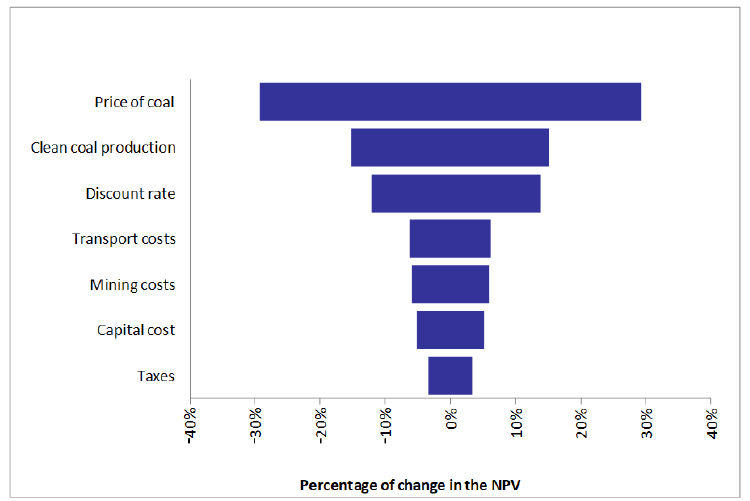
Figure 2. Tornado graph for D ę bie ń sko project financial